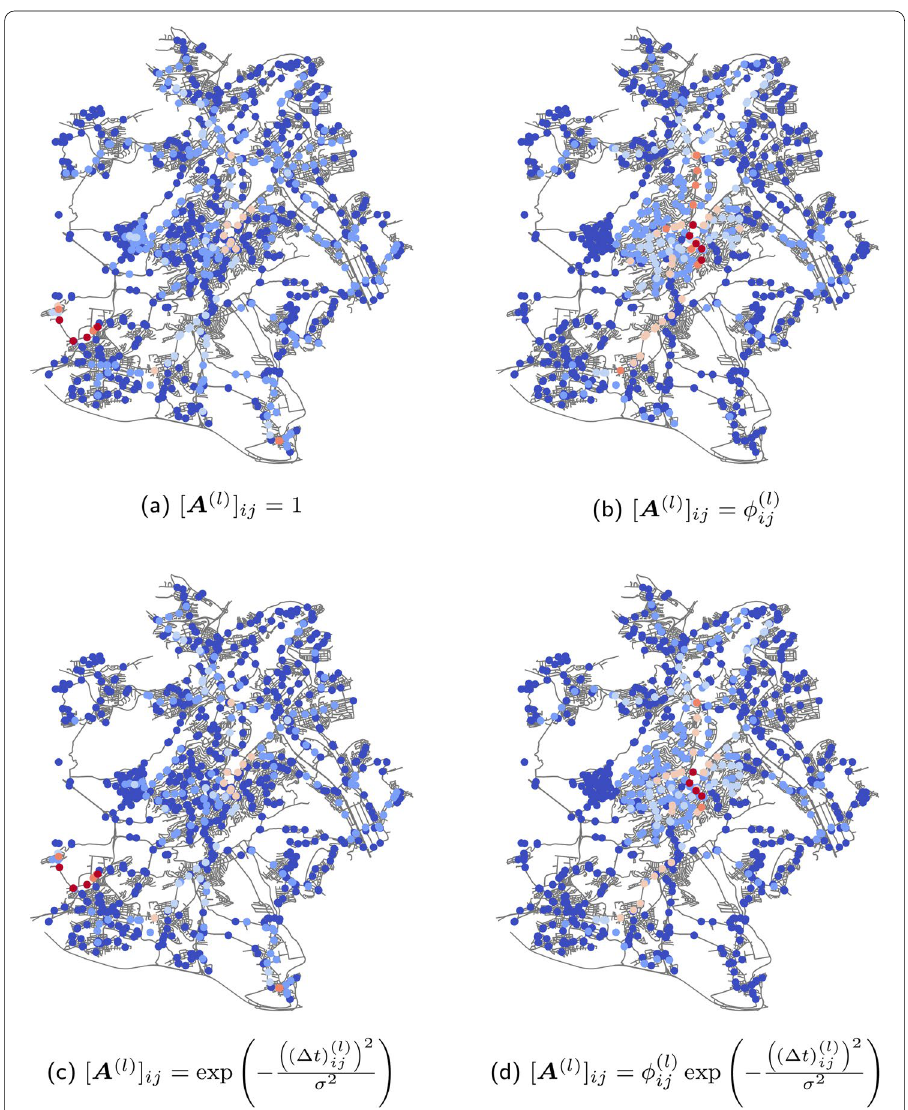
Fig. 9 Comparison of different weight models at the example of marginal node resolvent-based subgraph centralities of Stuttgart. Central stops are marked red and non-central stops are marked blue. The subcaptions denote the respective intra-layer weights [ A ( l ) ] ij in the case that nodes i and j are connected in layer l . Otherwise, [ A ( l ) ] ij is set to 0 in all cases. The plots in the first column are obtained without frequencies, whereas the plots in the second column are obtained with frequencies. The plots in the first row are obtained without a Gaussian kernel applied to travel times, whereas the plots in the second row are obtained with a Gaussian kernel applied to travel times. Furthermore, the same Gaussian kernel is also applied to inter-layer transfer times in the second row. The parameters are chosen as α = 0.5 / (cid:31) max , σ = 5 , and (cid:31) t transfer = 5 . The street network in the background of the plots is created with the OSMnx python package (Boeing